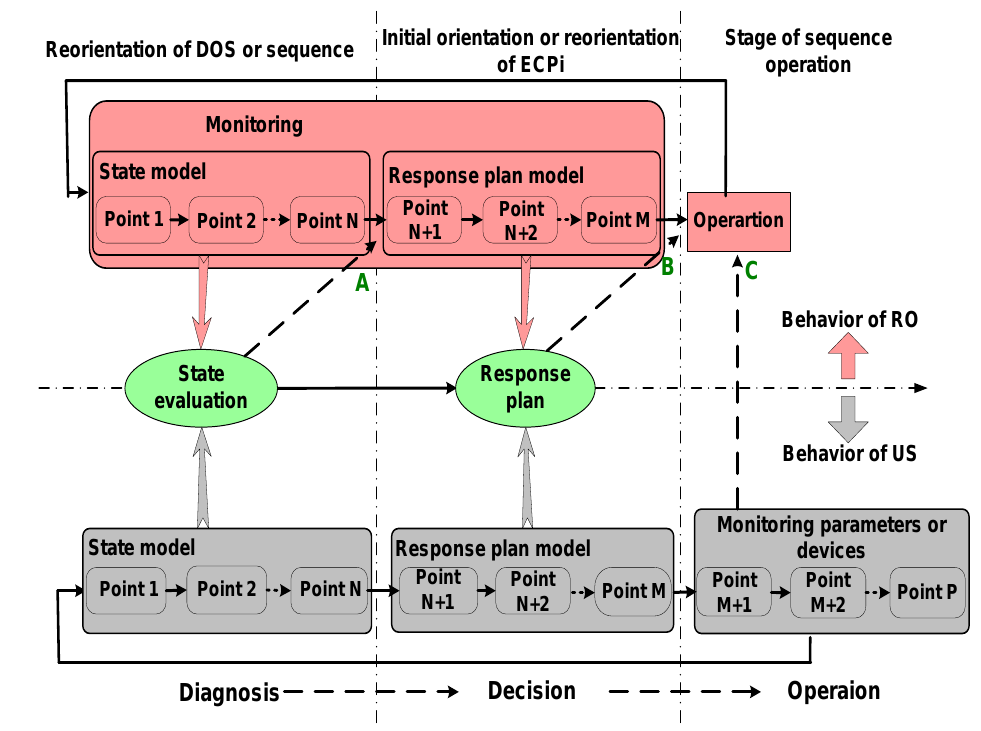
Figure 7. Team cognitive behavioral model.